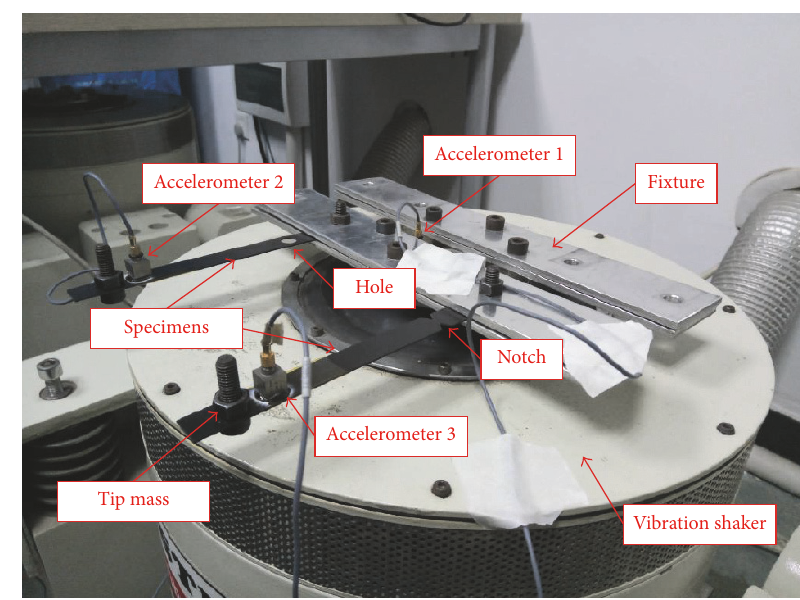
Figure 10: The fixtures of specimens, tip mass, and